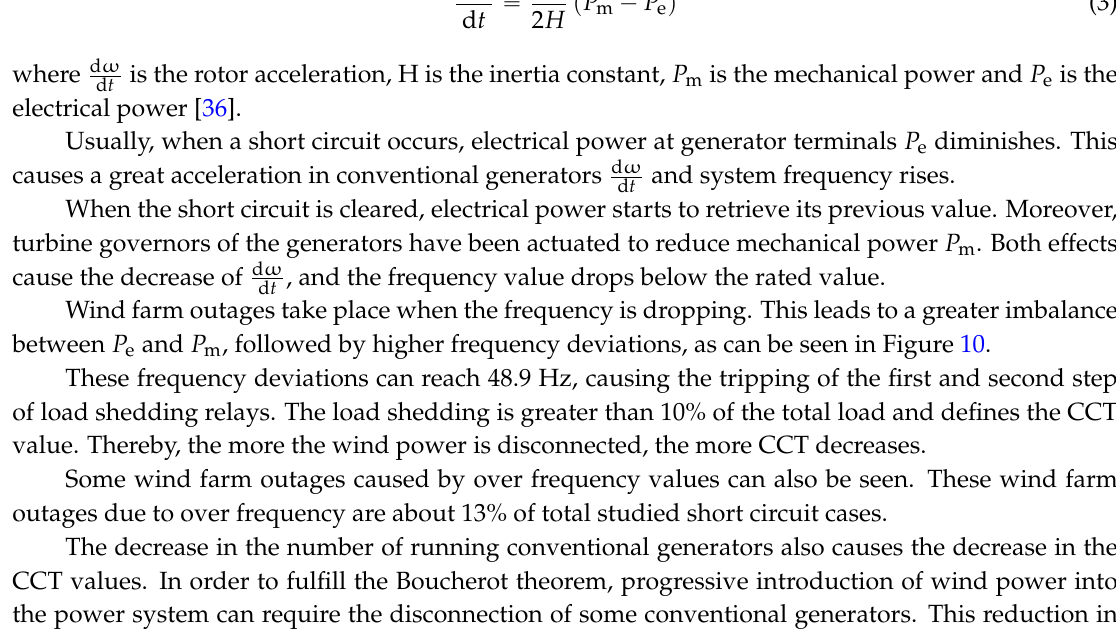
Figure 10. Time evolution of voltage and frequency for a three ‐ phase short circuit at: ( a ) Las Salinas substation, with 260 ms of clearing time and an SCIG wind turbine; ( b ) Punta Grande substation, with 230 ms of clearing time and a full converter wind turbine; and ( c ) Haría ‐ Teguise, with 420 ms of clearing time with a full converter wind turbine and with inertia emulation capability.